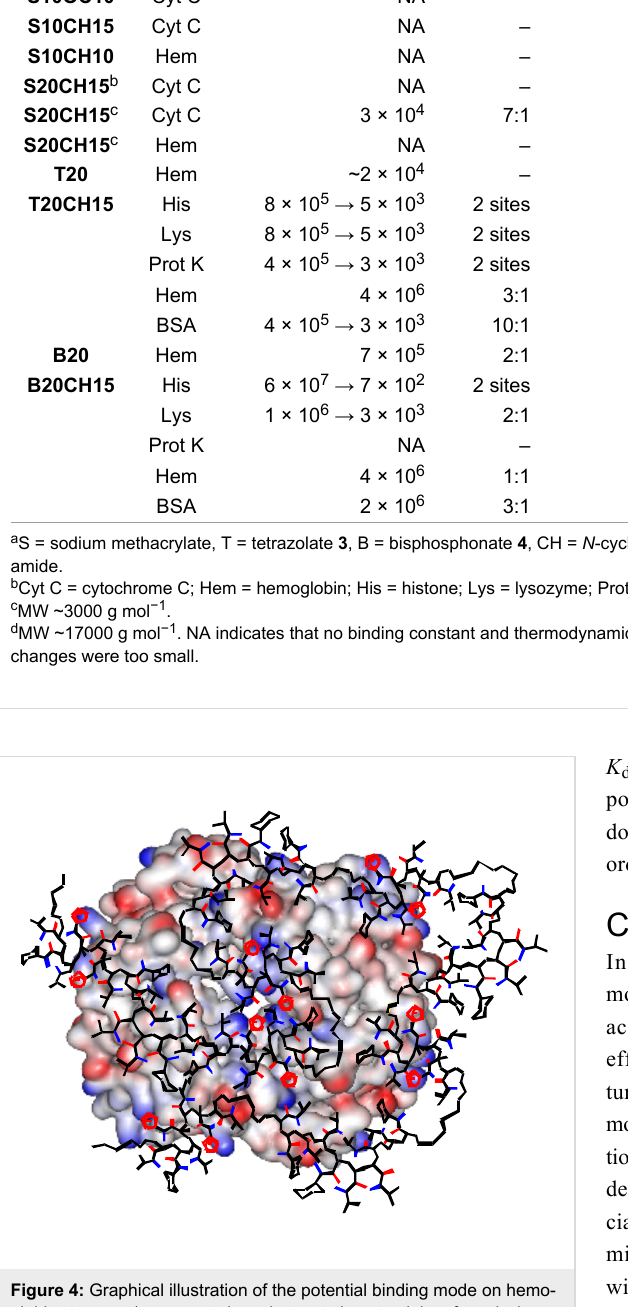
Polymer : protein